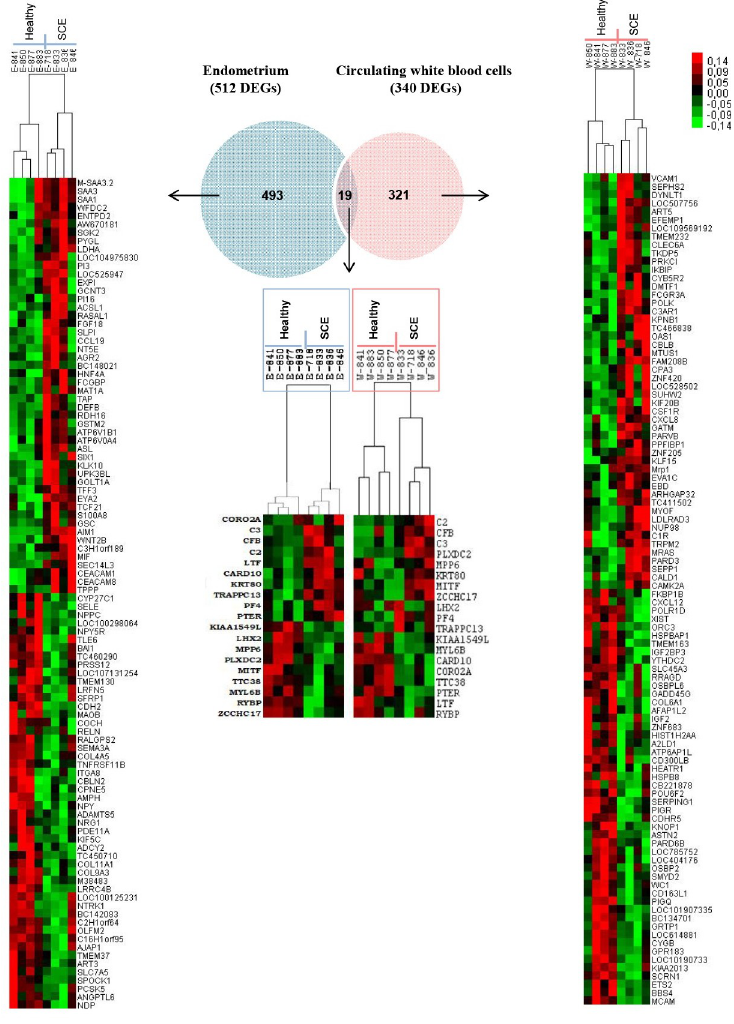
Fig 2. Venn diagram and Heat maps showing the molecular effects of subclinical endometritis on mRNA expression in endometrium and in circulating white blood cells (WBC). Differentially expressed genes between Holstein dairy cows with subclinical endometritis (SCE, n = 4 including follicular phase, n = 1; luteal phase, n = 3) and healthy (n = 4 including follicular phase, n = 2; luteal phase, n = 2) Holstein dairy cows were identified at 45–55 days postpartum (DPP) in endometrium and the WBC. In the Venn diagram, the number of DEG is indicated in brackets. For the endometrium and the WBC, the top 100 DEG (fold change � ± 1.5, t-test relative to a threshold probability, p- value � 0.05) are presented as heat maps (Cluster and TreeView software). Heat map expression values are represented as colors, where red squares indicate up-regulated DEGs and green squares indicate down-regulated DEGs.